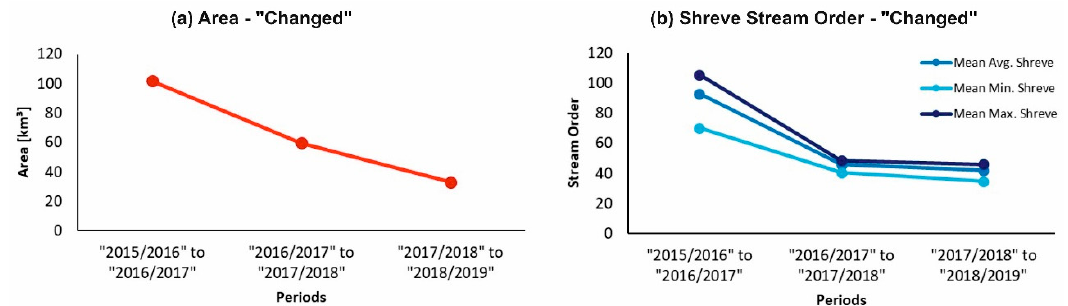
Figure 11. Summary statistics on classifications shown in Figure 10: ( a ) total area identified as “changed” per period and ( b ) mean values of Average (Avg.), Minimum (Min.) and Maximum (Max.) Shreve Order per period. Shreve order values were deduced from the hydrographic analysis of the SRTM DEM. Changed areas and Shreve order were linked via a spatial join.